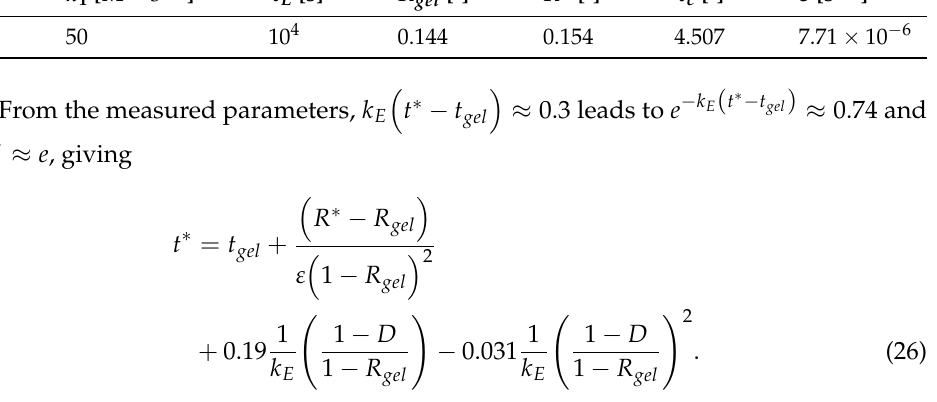
, similar to t gel . We obtained the ratio of t ∗ to t gel as 0